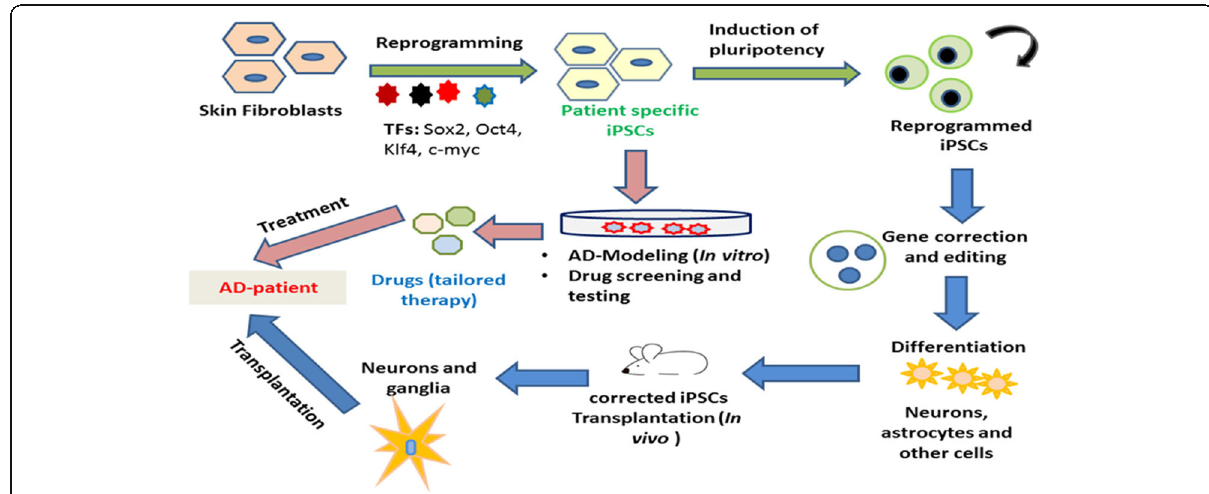
Fig. 4 The potential applications of iPSC-based therapy for AD. iPSC-based therapy is a therapeutic approach for replacing lost or damaged neural tissues. iPSCs could be used for generation of healthy neurons and astrocytes, by genetic modification, for in vivo transplantation. Moreover, iPSCs could act as an in vitro tool for AD modeling and anti-AD drug screening and